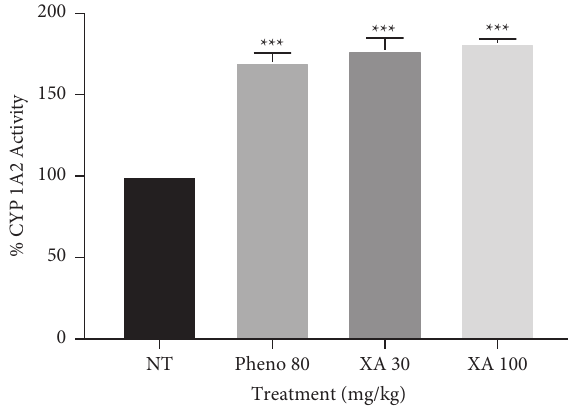
Figure 2: Effect of phenobarbitone (Pheno 80), xylopic acid low dose (30 mg/kg; XA 30), and xylopic acid high dose (100mg/kg; XA 100) on CYP 1A2 (MROD) enzyme activity. Data are presented as mean ± S.E.M. ∗∗∗ P < 0 . 001 compared to no-treatment group (one- way ANOVA followed by Tukey’s post hoc test).